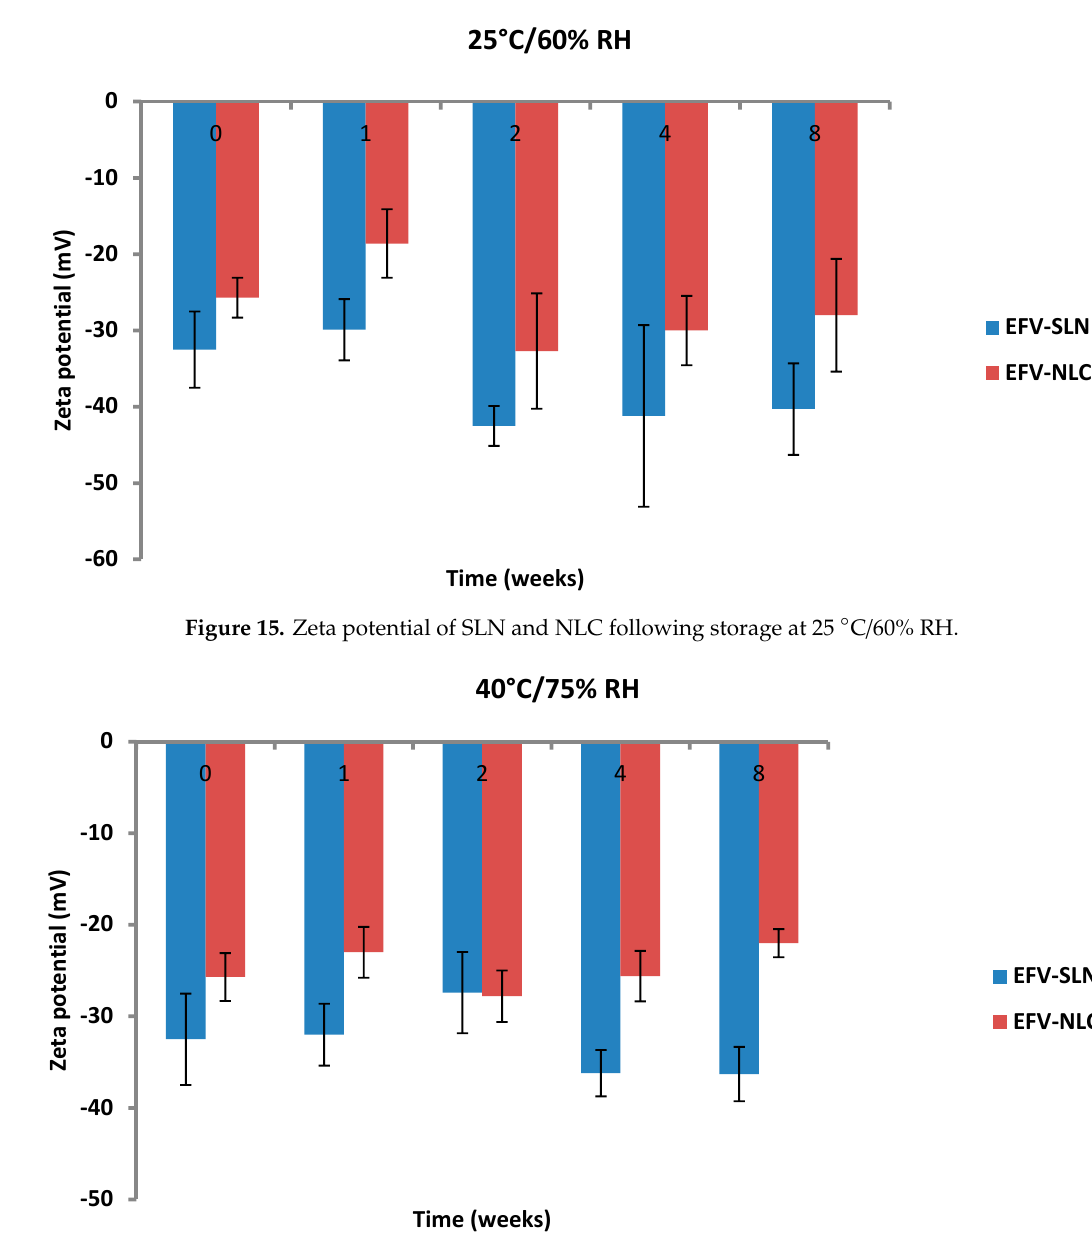
Figure 16. Zeta potential of SLN and NLC following storage at 40 °C/75% RH .